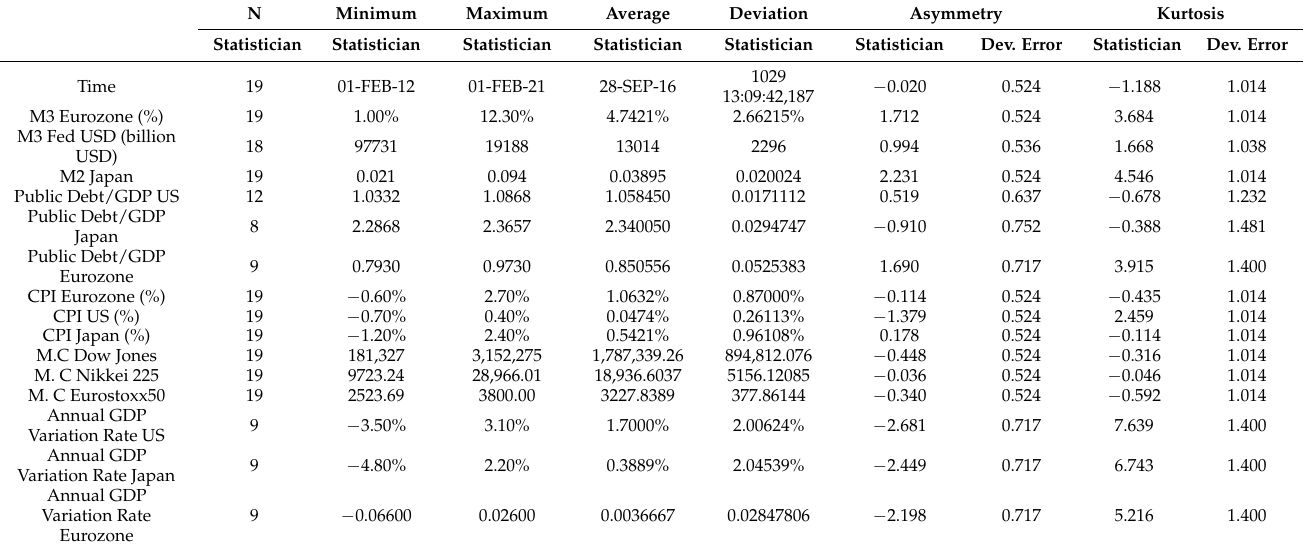
Table 1. Descriptive statistics.